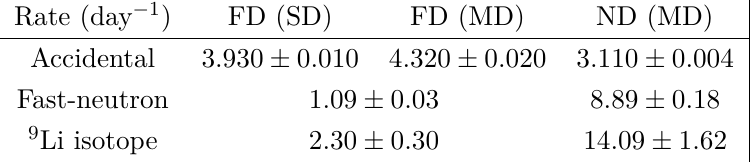
Table 1 . Background expectation in the 1.0–8.5 MeV window. The accidental, fast-neutron